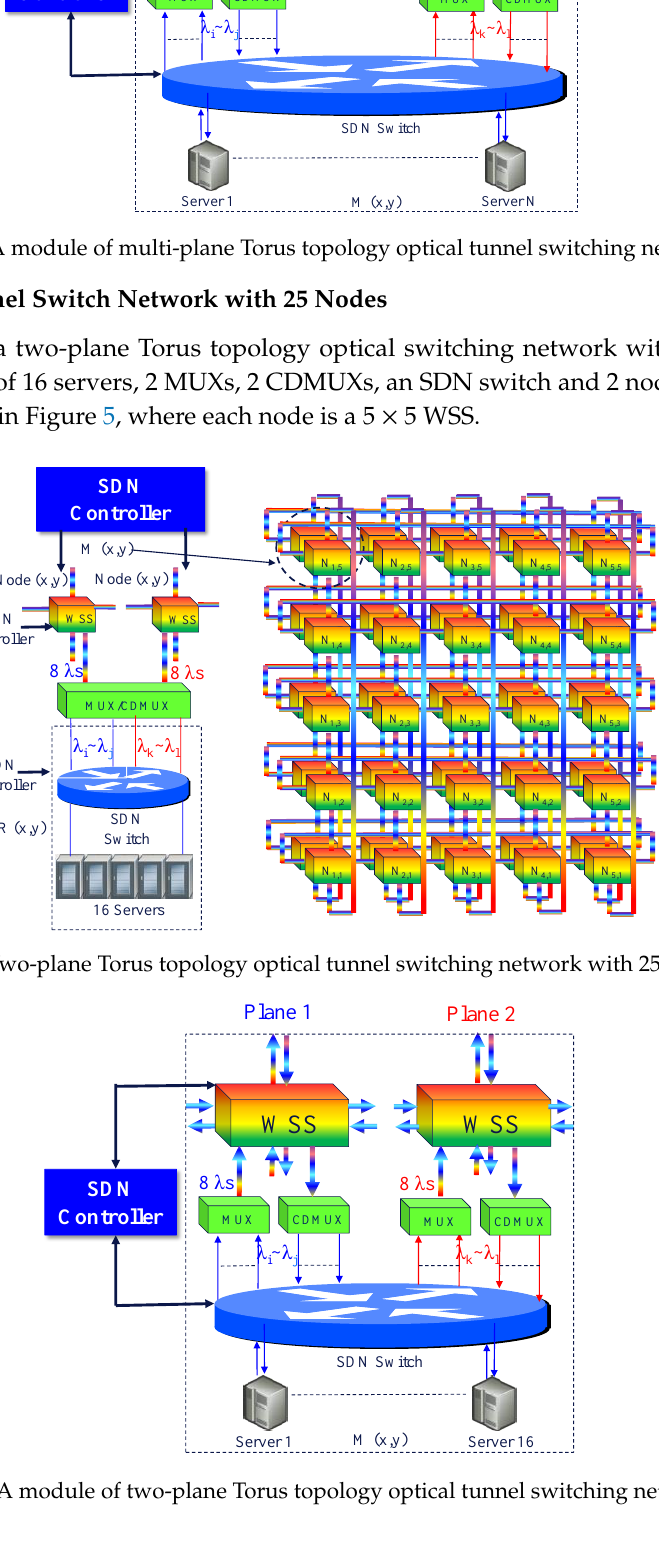
Table 1. X-axis and Y-axis wavelength assignment of each node. Node